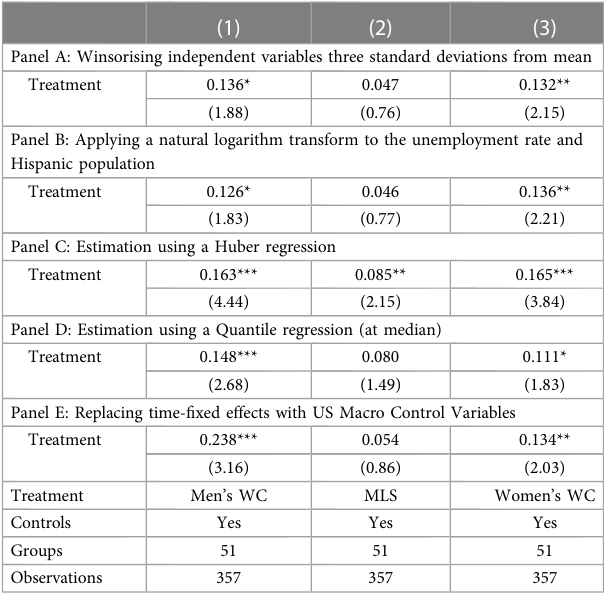
Panel A: Winsorising independent variables three standard deviations from mean